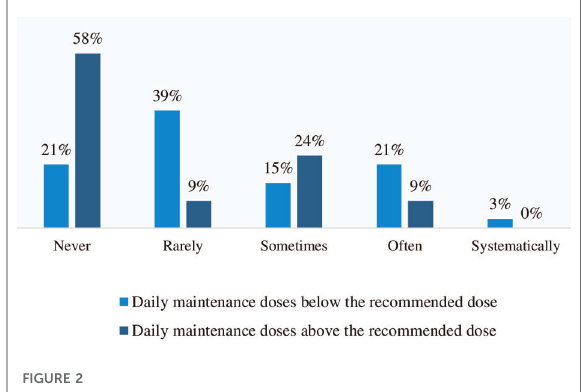
FIGURE 2 Medical practice in terms of dose adaptation at the end of the initiation phase as reported by the respondent physicians ( n =33).